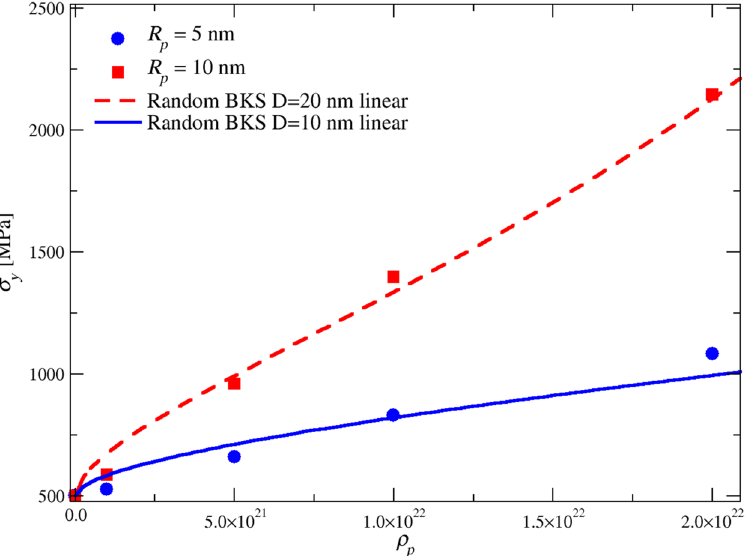
Figure 4. Yield stress as a function of precipitate density from simulations (symbols) and from the modified Bacon-Kocks-Scattergood (BKS) equation [Eq. (3),